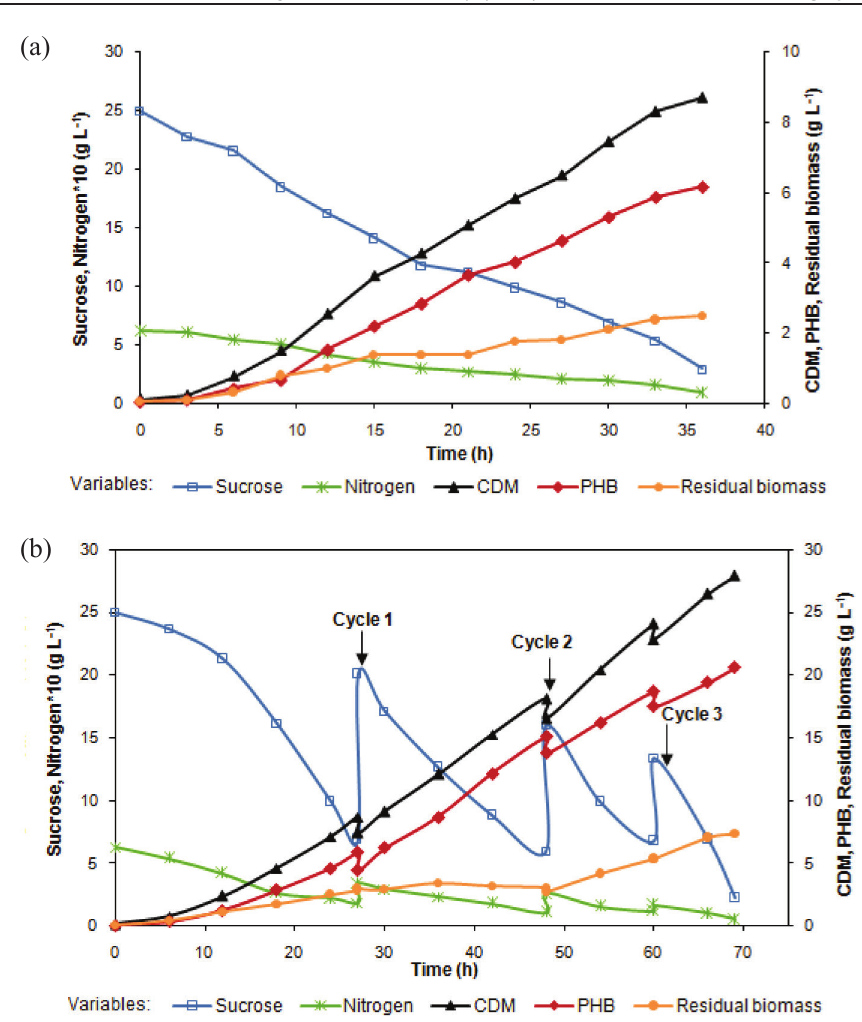
Fig. 2 – (a) Batch kinetics of cell growth, nutrient consumption, and PHB production for A. australica in the 7-L bioreactor (b) repeated-batch cultivation kinetics of A. aus- tralica for PHB production. Three cycles of repeated-batch were performed at 27 h, 48 h and 60